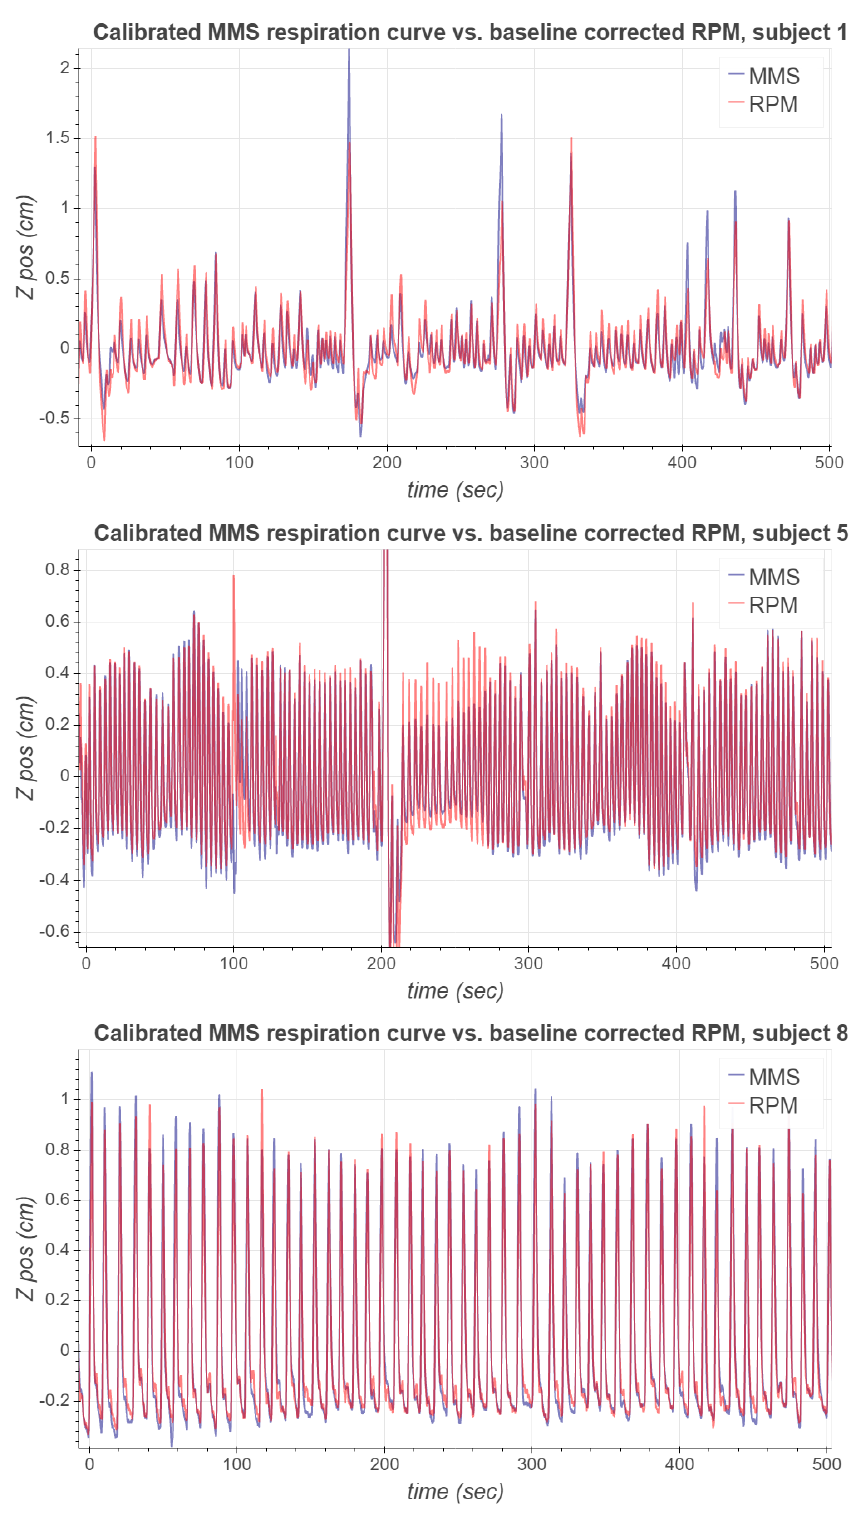
Figure 10. The first 500 s of the calibrated MMS and the baseline drift-corrected RPM respiration signals corresponding to subjects 1, 5 and